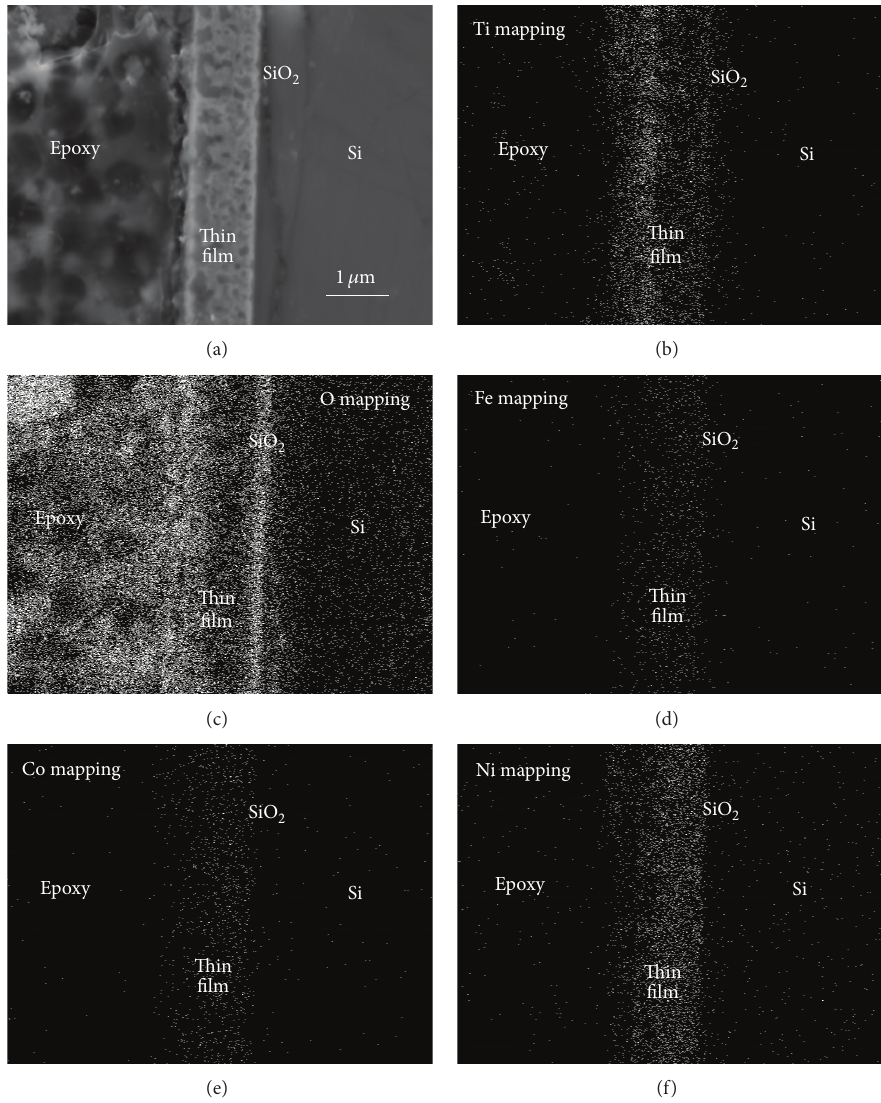
Figure 7: EPMA analyzed result. (a) The cross section SEM micrograph of the TFCNO thin film after annealing at 1000 ∘ C for 30 min and the corresponding element mapping of (b) Ti; (c) O; (d) Fe; (e) Co; and (f)